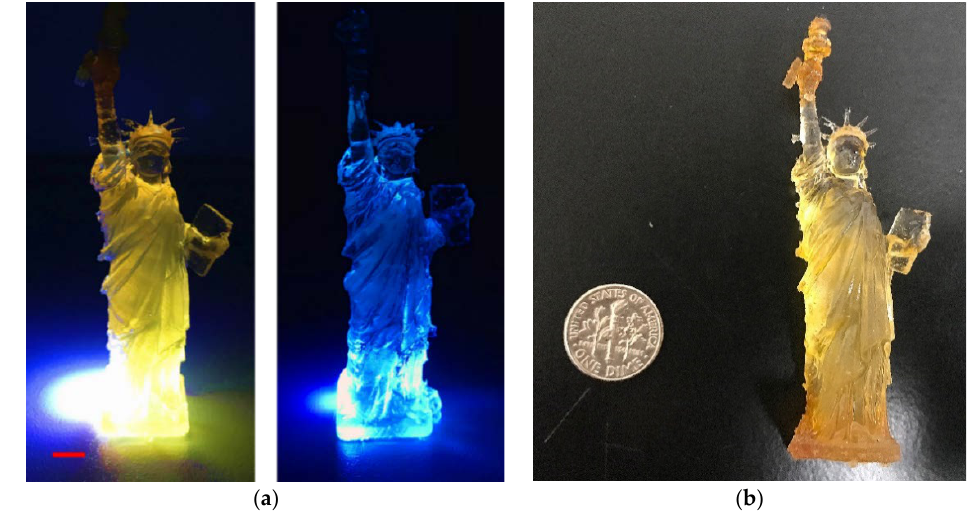
Figure 8. ( a ) 3D printing of the Statue of Liberty using ( left ) O-CDs and ( right ) control. (The bar is 5 cm); ( b ) The comparison of the specimen with a US dime.